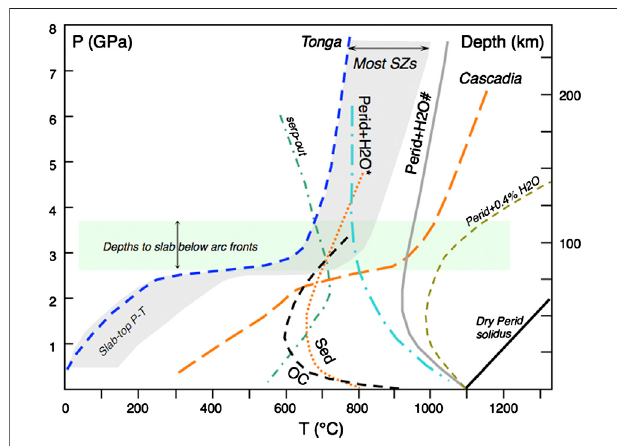
FIGURE 2 | Depth pro fi les of slab-surface temperature are shown for global subduction zones (gray shaded fi eld for most) based on numerical models of Syracuse et al. (2010), assuming full coupling between slab and mantle to a depth of 80 km. Extrema are shown for the coolest (Tonga) and hottest (Cascadia) SZs. The upper stability limit of serpentine is shown by the “ serp-out ” curve (Ulmer and Trommsdorff, 1995), and wet-melting solidus curves are shown for oceanic crust ( “ OC ” ; Vielzeuf and Schmidt, 2001) and marine sediments ( “ Sed ” ; Poli and Schmidt, 2001; Hermann and Spandler, 2007). For wet-melting of mantle peridotite, two solidus curves are shown owingtounresolvedcontroversybetweenGroveetal.(2012;lowerTsolidus*) and Green et al. (2014, higher T solidus#); both are substantially cooler than the dry peridotite solidus ( ∼ 1,450 ° C at 100 km depth; Hirschmann, 2000). At sub-arc depths, the hot Cascadia slab is expected to have undergone signi fi cant dehydration. If water is present (e.g., from the slab interior), the ocean crust and sediment portions of the slab are likely to partially melt, as might deep parts of the overlying mantle wedge. At similar depths (ca. 100 km)beneathmostotherSZs,theslabsarelikelytoretainasigni fi cantpart of their water inventory and in many cases be too cool to undergo partial melting. Whether or not the lowermost mantle wedge can produce hydrous meltsdependsonwhichwet-soliduscurveisapplicable,andonthemannerin which slab-derived fl uids or melts are transferred into the mantle wedge (cf. Cerpa et al.,